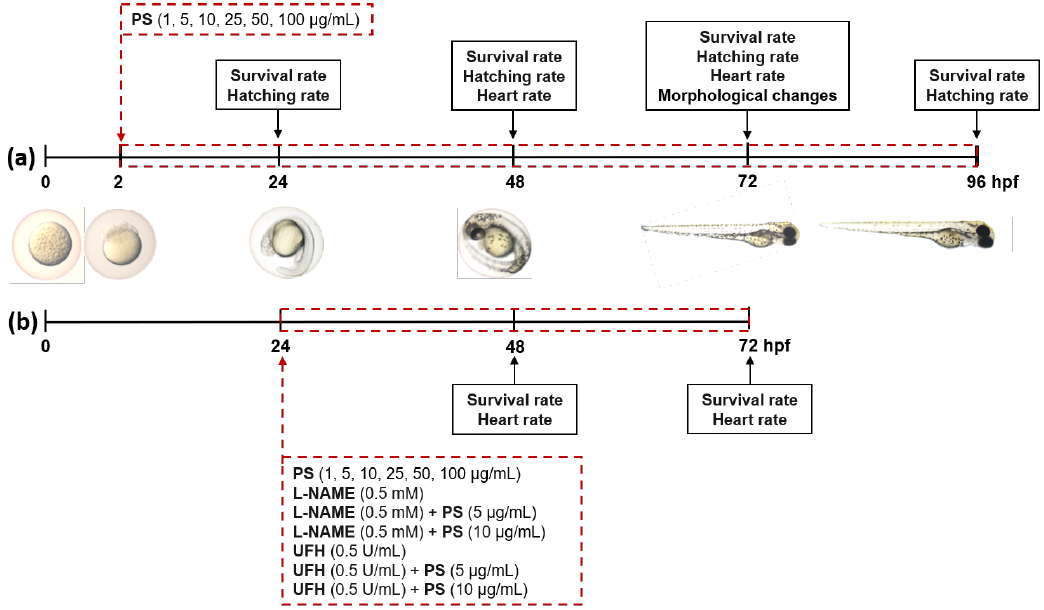
Figure 1. Schematic representation of 94 h ( a ) and 48 h ( b ) exposure of zebrafish to the full range of protamine sulfate (PS) concentrations, N(ω)–nitro– L –arginine methyl ester ( L –NAME), and unfractionated heparin (UFH), alone or together with PS. Abbreviations: hpf, hour post-fertilization.